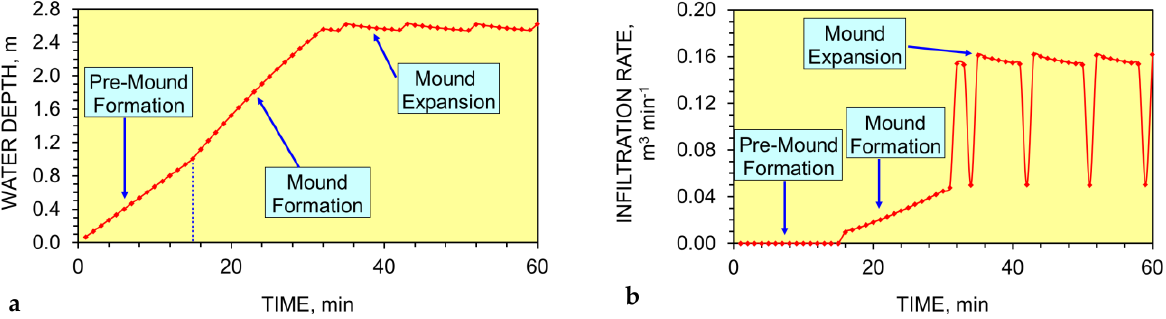
Figure A13. Groundwater stationary mound formation; ( a ) infiltration device water depth versus time; ( b ) infiltration rate versus time.